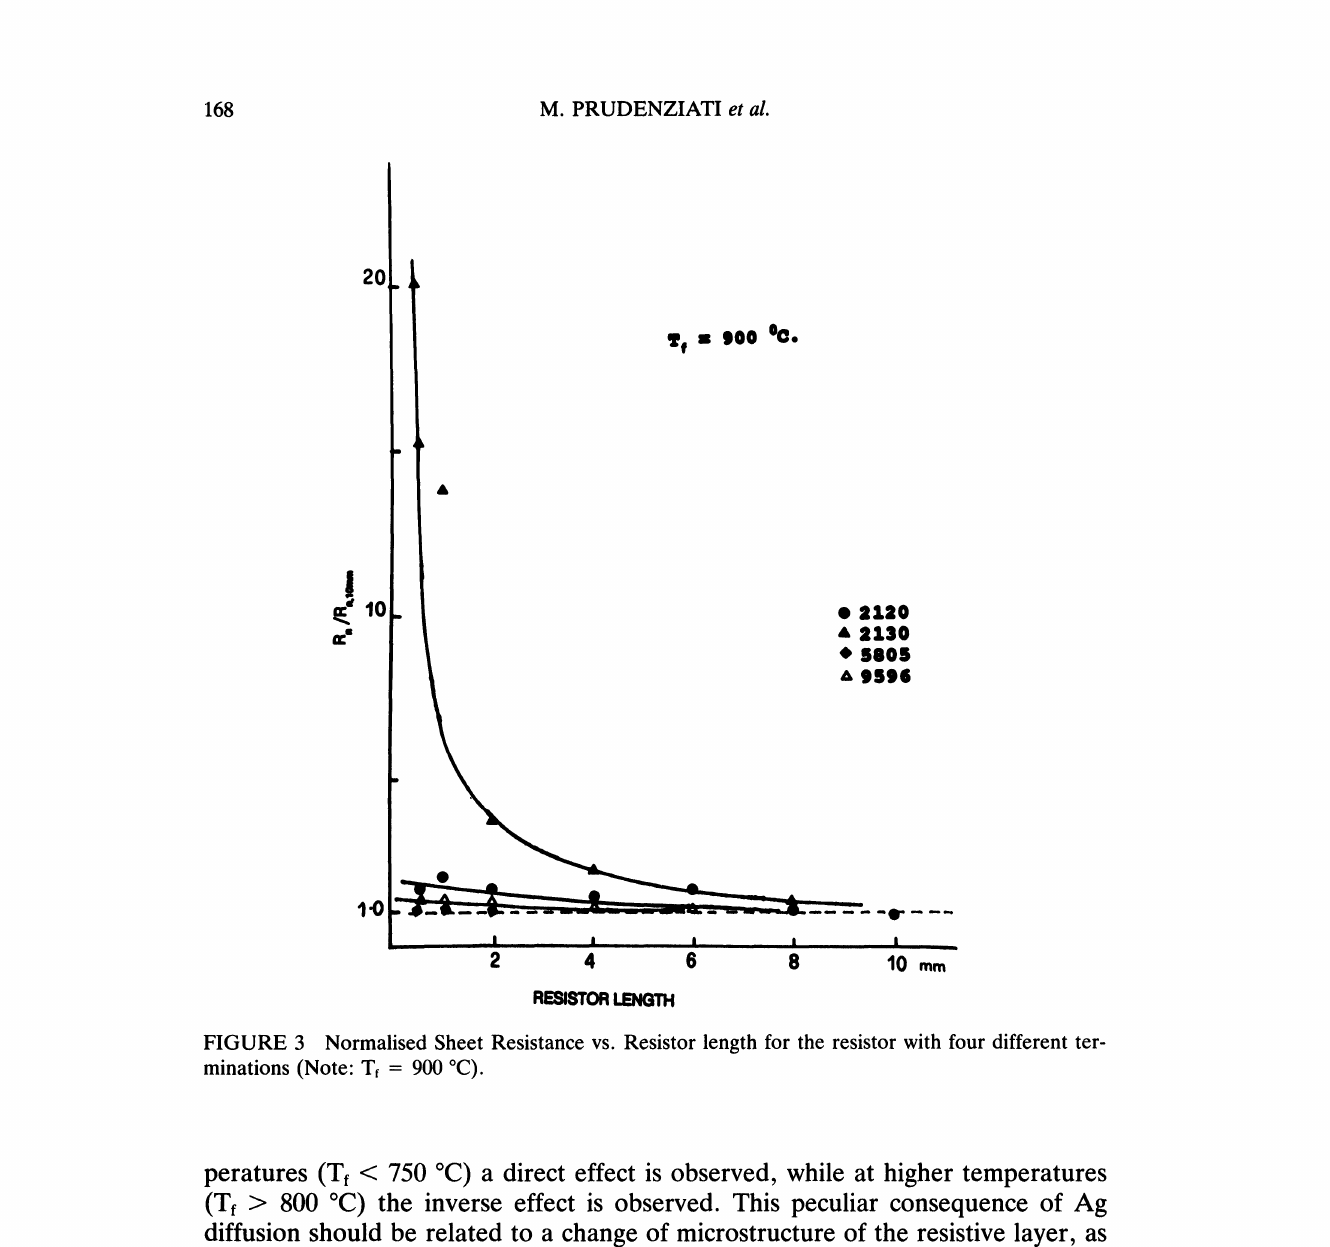
FIGURE 3 Normalised Sheet Resistance vs. Resistor length for the resistor with four different ter- minations (Note" Tf 900